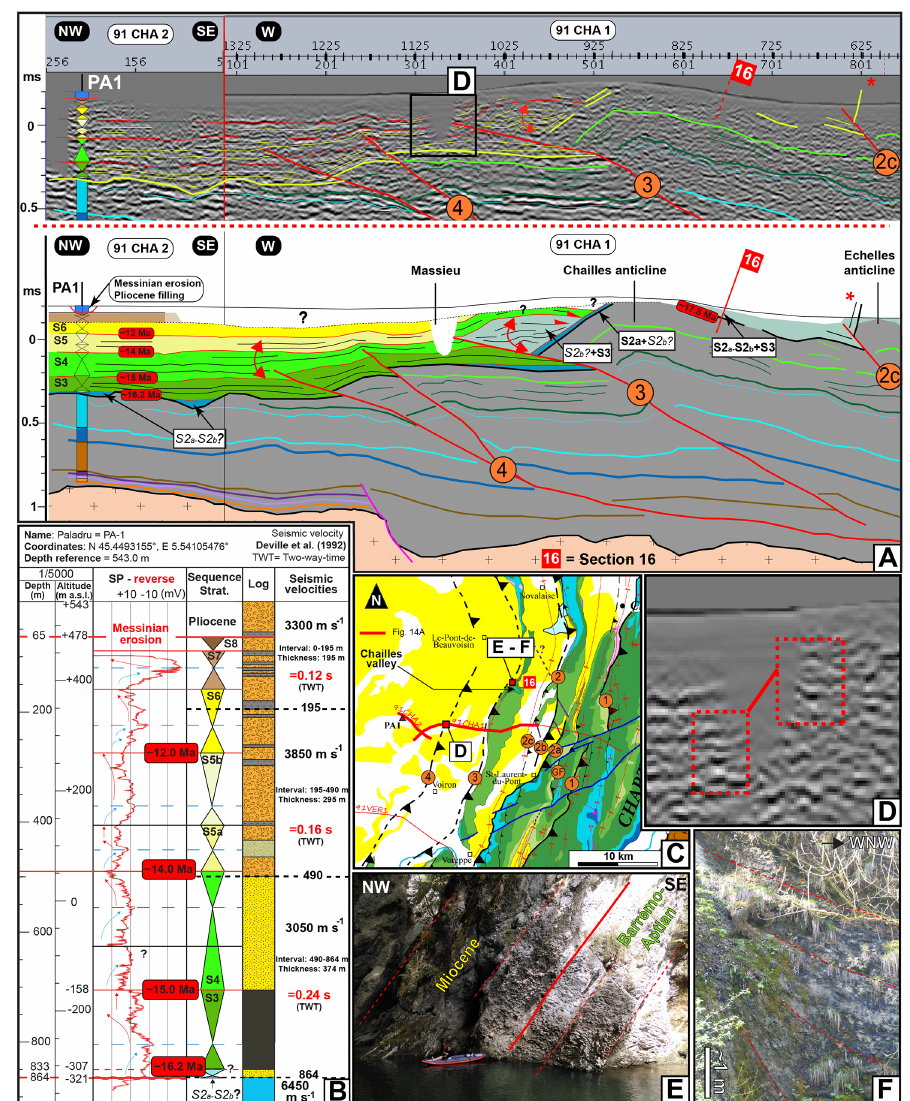
Figure 14. Growth strata relationships inferred for FZ3 and FZ4 based on the 91CHA1 and 91CHA2 seismic profiles, sequential interpre- tation of the PA-1 well, and fieldwork observations. The ages in red boxes correspond to the homogenized ages of the eustatically driven transgressions (Fig. 4B). Orange circle: fault zone (FZ). (A) Seismic profiles 91CHA1 and 91CHA2 depicting the Miocene reflectors and geometrical relationships associated with FZ3 and FZ4. The red double-curved arrows point to the growth strata. Legend in Fig. 9. (B) Se- quential interpretation of the PA-1 well and conversions of sedimentary thicknesses into seismic velocities (Deville et al., 1992). Legend in Fig. 15. SP-reverse: reversed spontaneous potential curve (in response to water saturation) in millivolts (mV). (C) Geographical and geolog- ical locations. Legend in Fig. 1. (D) Zoomed-in view of the Massieu area (see location in A ) showing similar seismic facies on both sides of the Massieu artifact and suggesting east side up offset across FZ3. (E) Tilted concordant Urgonian–Miocene basal conglomeratic contact (S2a). (F) Growth strata relationships at approximately 20 and 30m above the river level, corresponding to S2b or S3 deposits according to regional correlation